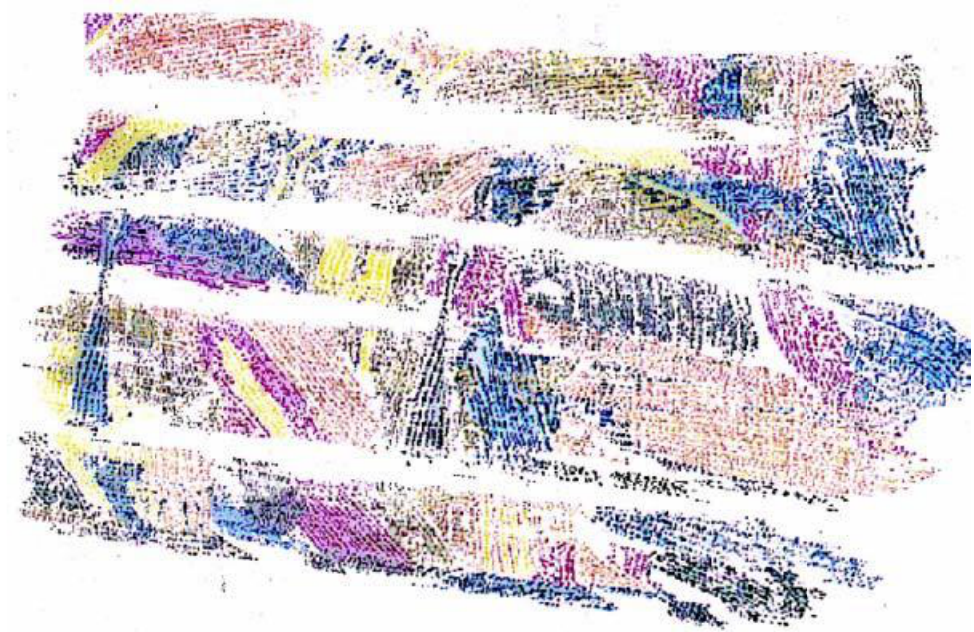
Figure 17. OCEAN Johan Bettum, Kim Baumann Larsen, Birger Sevaldson, 1998. “The Colour Graft.” Source material for a long series of experiments. The information derived from this source material evolved through several projects: Synthetic Landscape 1997, Synthetic Pavilion 1999, and Ambient Amplifiers 2000. The concept inspired the development of the digital techniques in OCEAN NORTH [19] (p. 147). Reproduced with the permission of Sevaldson.